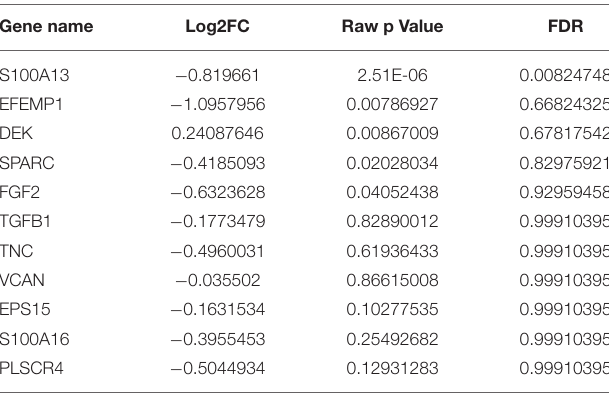
TABLE 7 | mRNA expression of related proteins in